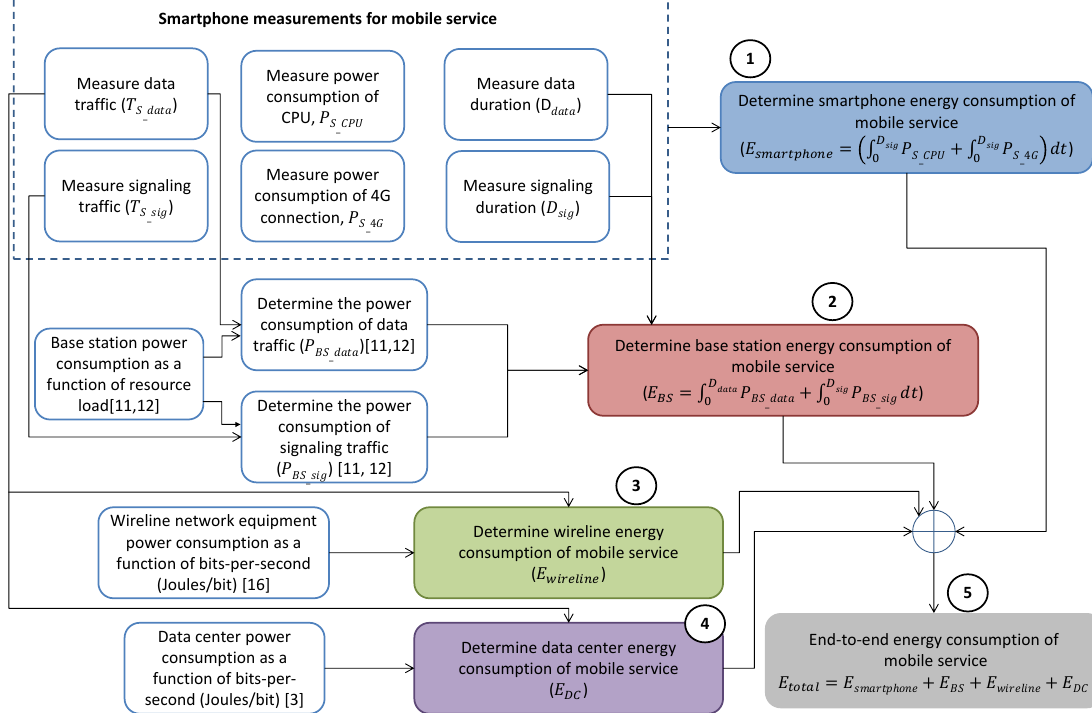
Figure 2. Service-specific end-to-end energy assessment methodology.